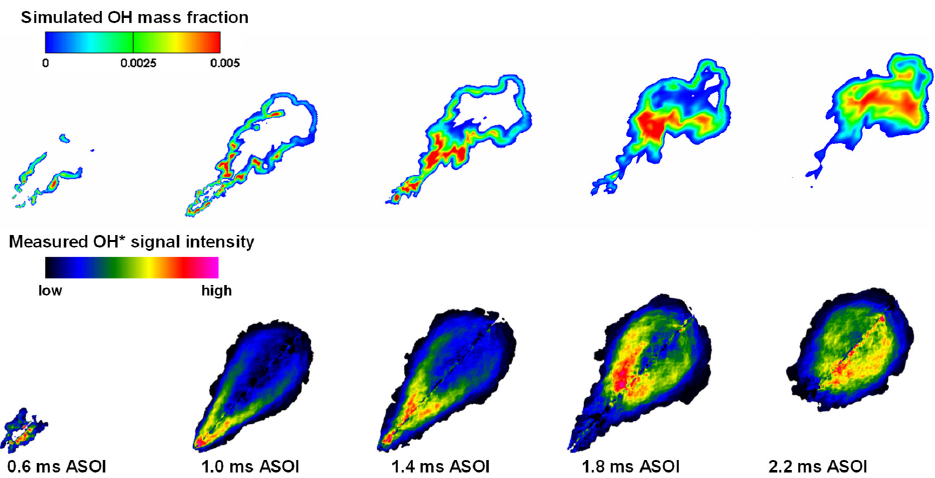
Figure 3. Simulated and measured OH-species during the ignition of a diesel spray.